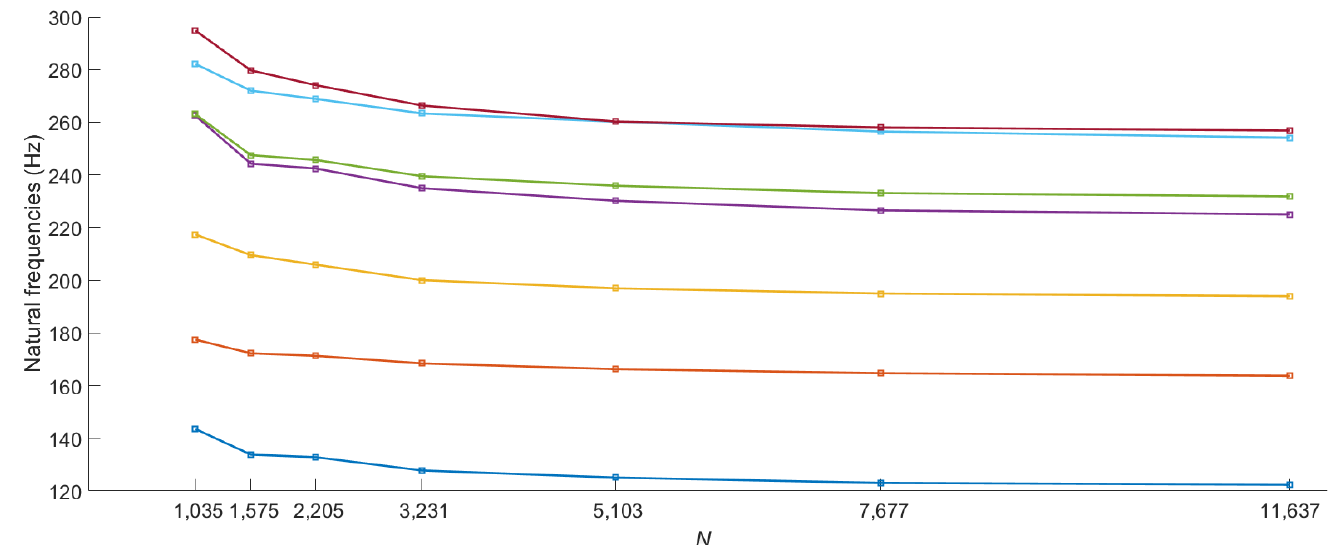
Figure 2. The convergence of the first seven fingertip natural frequencies to their final values as the number of nodes in the model was exponentially